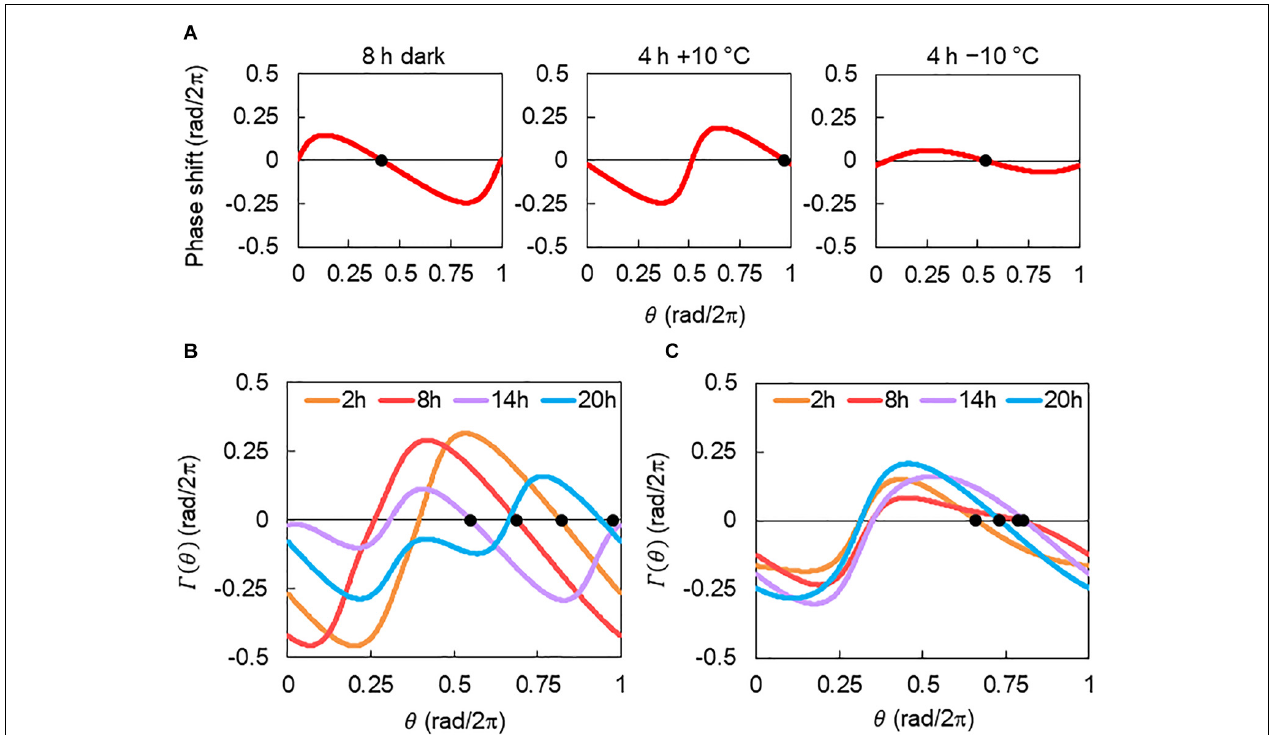
FIGURE 8 | Description of combined phase response curve (PRC). (A) PRCs for 8 h dark and 4 h ± 10 ◦ C stimuli. PRCs were reconstructed with a = 0.20 and α = 0.13 for 8 h darkness, a = 0.39 and α = 0.58 for 4 h +10 ◦ C, and a = 0.10 and α = 0.13 for 4 h − 10 ◦ C stimuli (Masuda et al., 2021). Black dots indicate the stable points. (B) The combined PRC (cid:48) ( θ ) of 8 h dark and 4 h +10 ◦ C condition. (C) (cid:48) ( θ ) of 8 h dark and 4 h − 10 ◦ C condition. Each curve corresponds to (cid:48) ( θ ) for (cid:49) t = 2, 8, 14, or 20 h. Black dots indicate the stable point of each (cid:48) ( θ